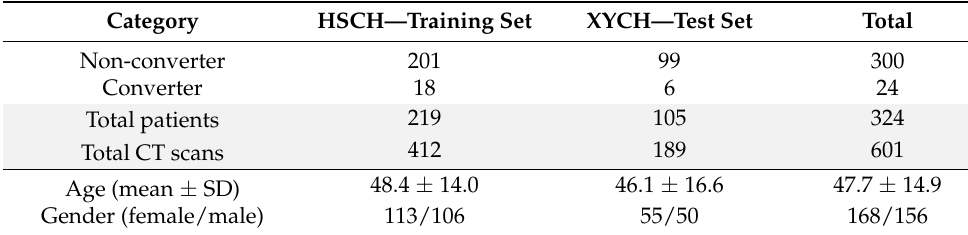
Table 2. Demographics of the patients in Task 2